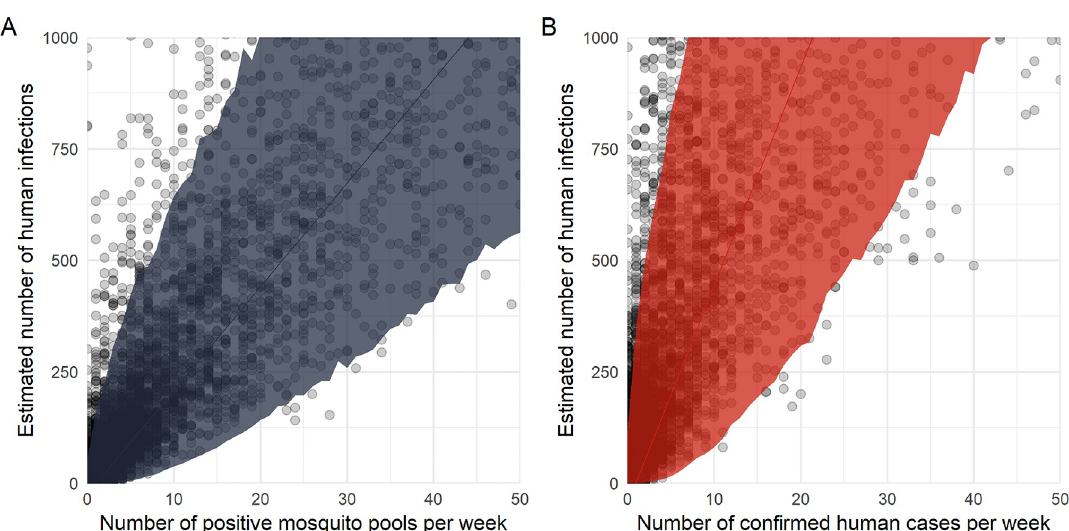
Fig 3. Relationship between the number of simulated Zika virus positive mosquito pools and human infections, and estimated incidence rate of human infections. Panel A shows the estimated incidence of human infections per week by the number of Zika virus positive female Ae . aegypti pools per week. Panel B is the estimated incidence of human infections per week by the number of infections in emergency department patients with two or more Zika virus symptoms per week. The lines are Bayesian negative binomial regression models fitted to predict the estimated incidence of human infections from the number of positive mosquito pools and the number of humans with two or more symptoms. The bands represent 95% credible intervals.